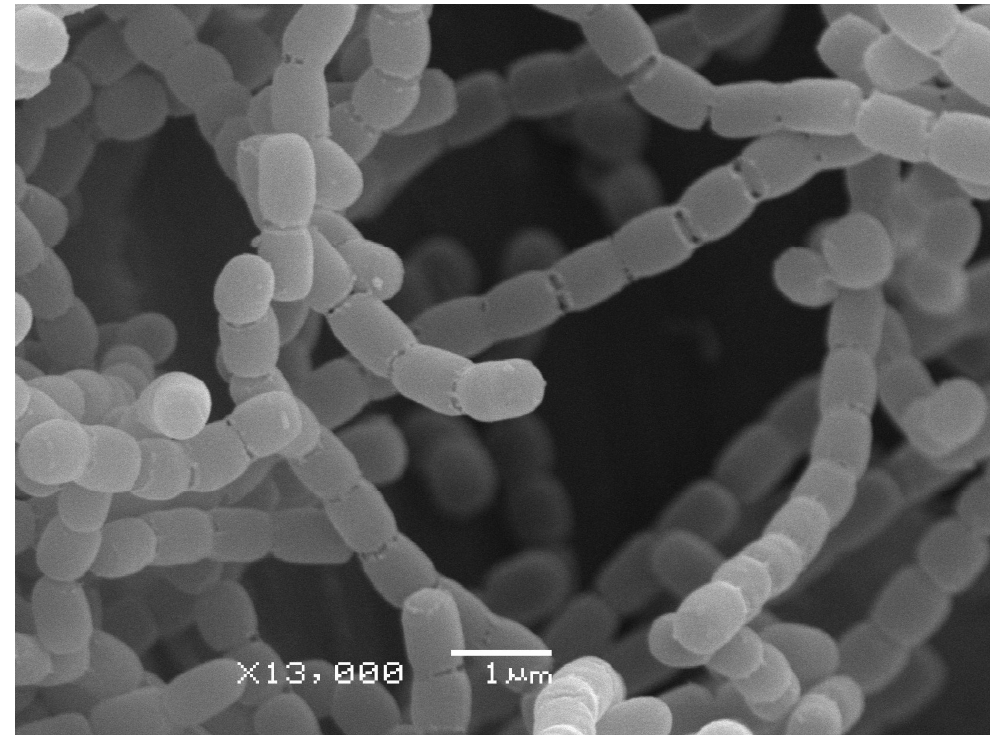
Figure 2. Scanning electron micrograph of the strain Streptomyces globisporus subsp. globisporus 4-3, showing the spore surface after incubation on ISP 3 medium at 28 °C for 14 days.